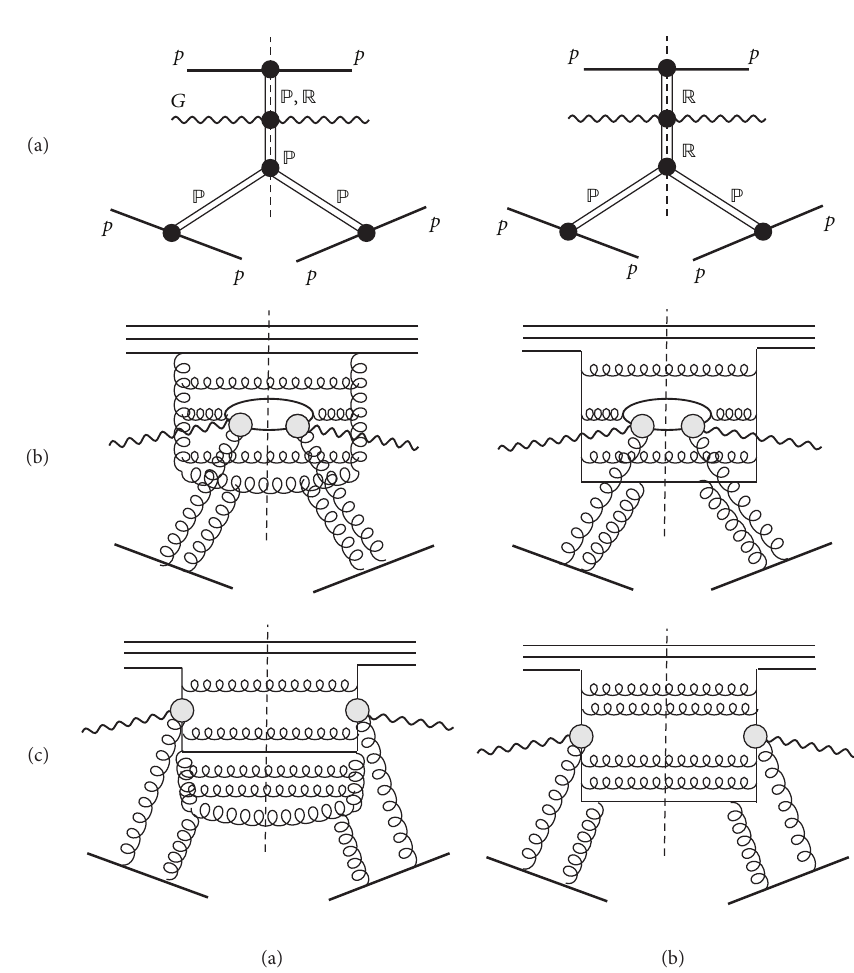
Figure 5: The upper row contains the triple-Regge graphs for 𝑝𝑝 → (𝑋𝐺 ∗ ) + 𝑝 . A few key examples of diagrams for diffractive excitation of a large invariant mass are given by 2nd and 3rd